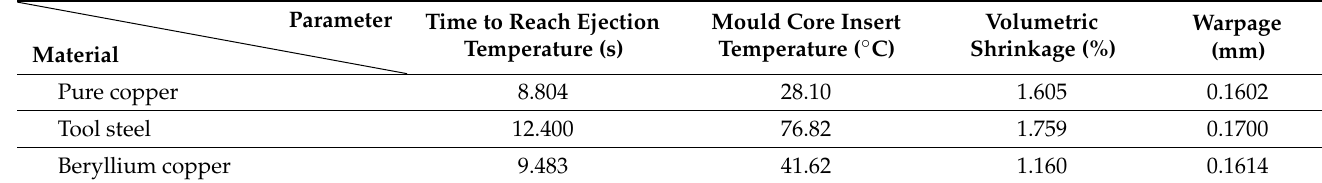
Table 3. Simulation results of mould inserts by researchers